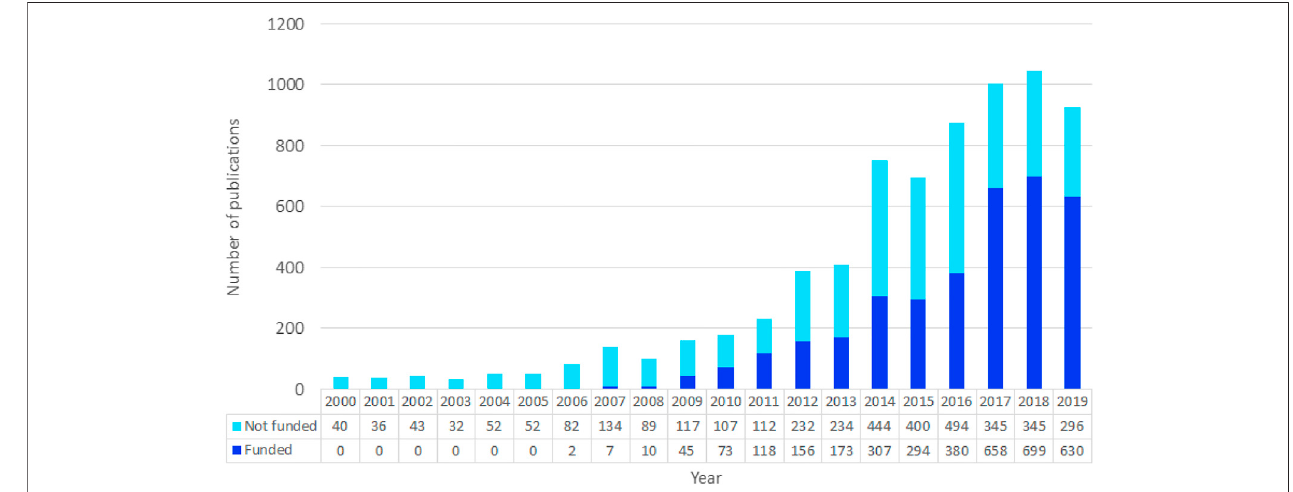
FIGURE 10 | Funding evolution for CSP publications.